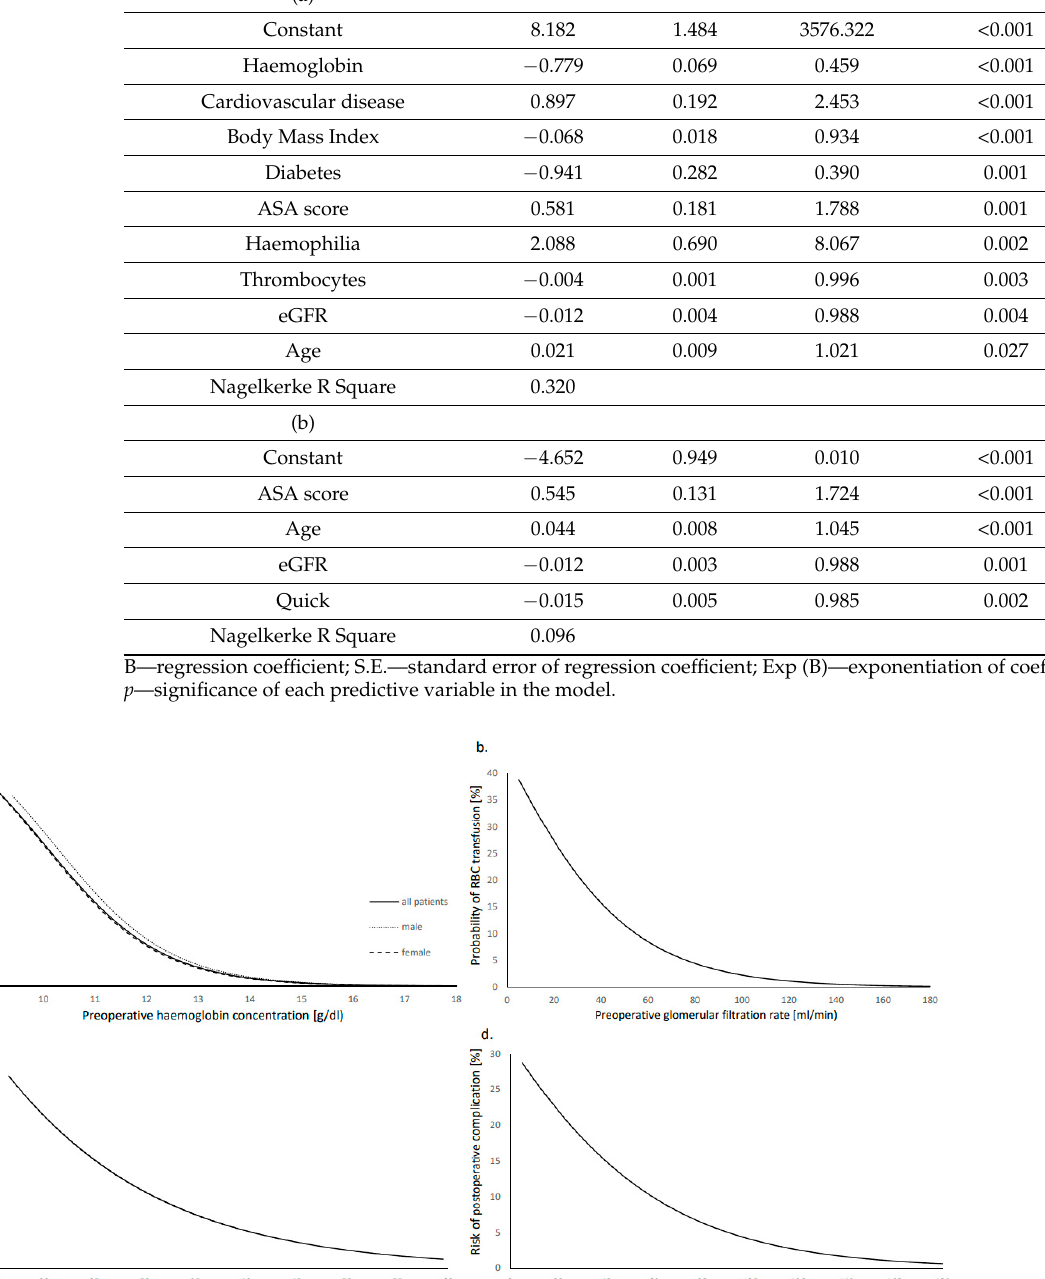
Table 2. Logistic regression models to predict allogeneic RBC transfusion (a) and perioperative complications (b).